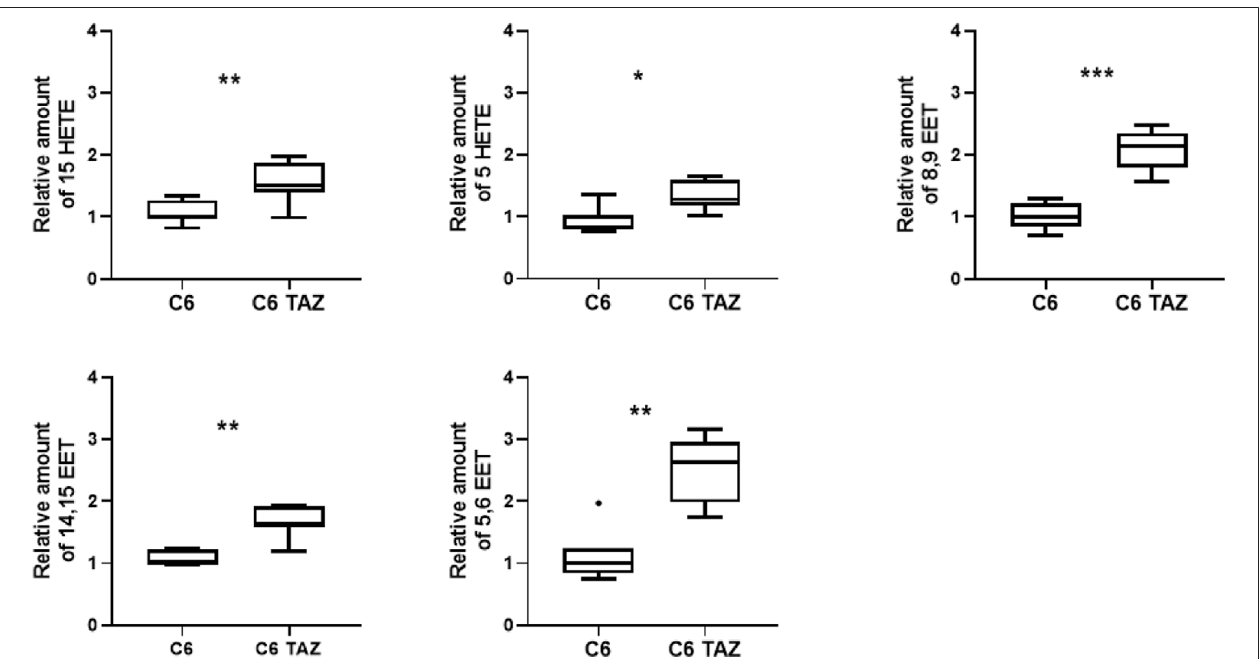
FIGURE 1 | Tafazzin de fi ciency alters oxylipin levels in C6 cells: Effect of tafazzin knockout on cellular lipids, oxylipinswas determined by HPLC-MS/MS. The Data analysis was performed with Agilent Mass Hunter Qualitative and Quantitative Analysis software (version B.08.00 for both). For all detected oxylipins, a relative quanti fi cationwasdonebynormalizingtheareaofthemetabolitesignaltotheareaofthesignaloftheinternalstandardcompound(relativeamount).Dataisrepresented as median,quartile and interquartile range for n =